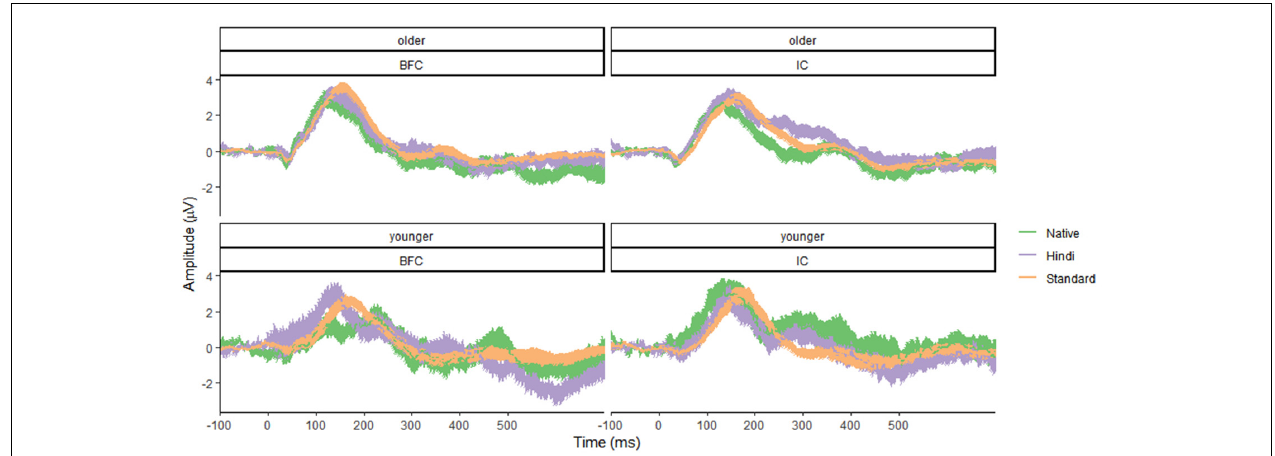
FIGURE 1 | Mean amplitude characteristics of event-related potential (ERP) waveforms in the younger (bottom panel) and older (top panel) groups of participants—biological family (BFC, left panel) and children raised in institutional settings (IC, right panel) in response to three types of stimuli: Foreign Deviant, Native Deviant, and Standard. Shaded areas represent confidence